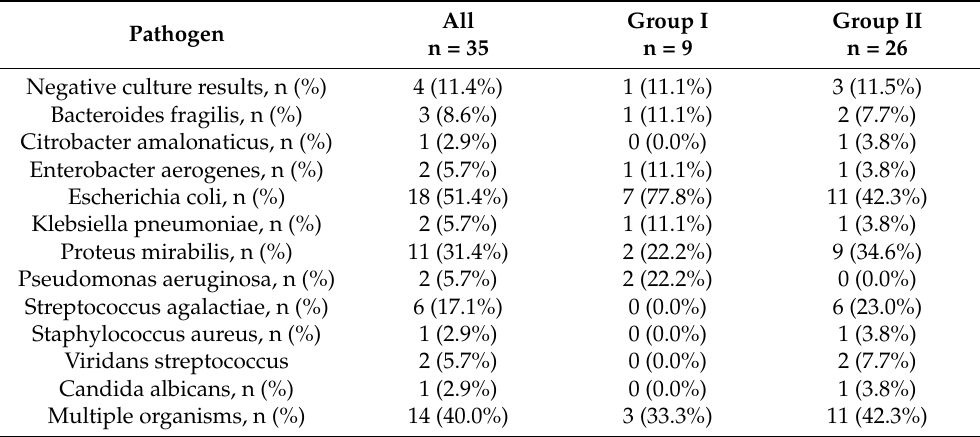
Table 3. Pathogens detected in preoperative urine and perinephric abscess